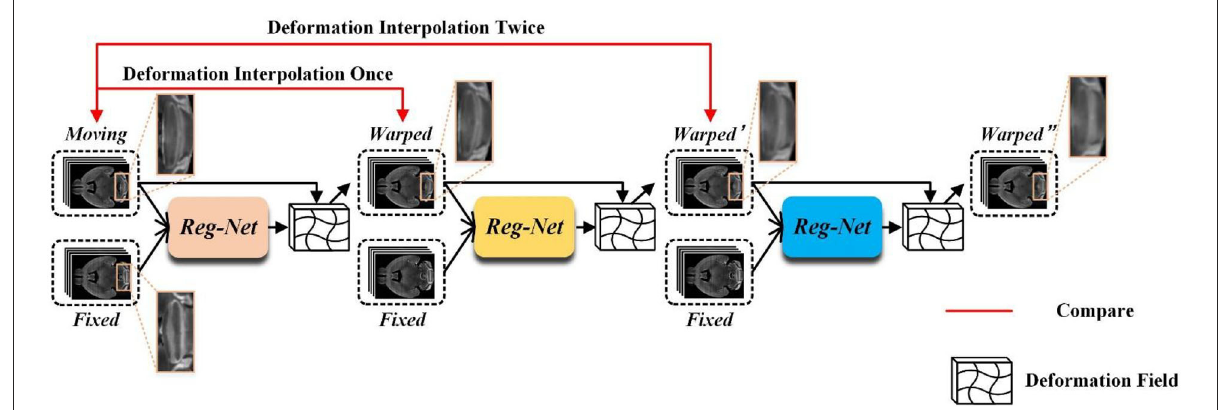
FIGURE1 The example of three-stage cascaded network registration methods. Three different colored modules represent registration models with the same structure but no shared